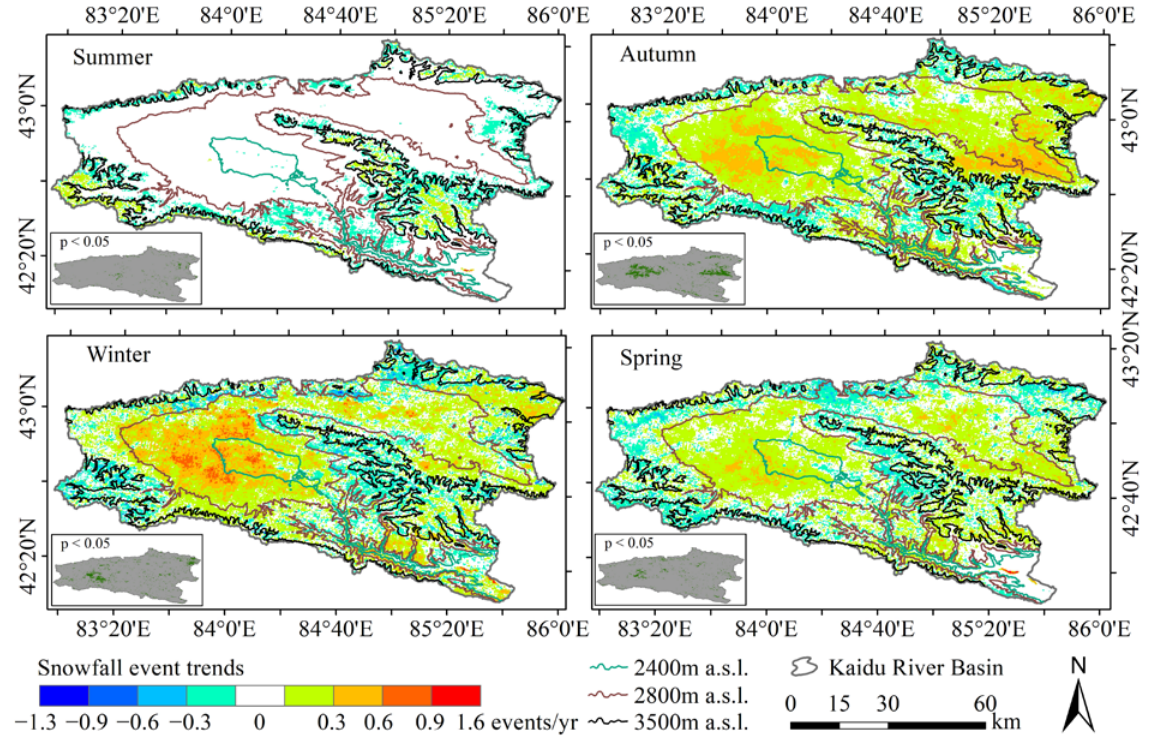
Figure 11. Spatial distributions of the seasonal trends in the frequency of snowfalls over the KRB from June 2000 to May 2020, where the green areas in the inset figure represent significant trends at a 95% ( p < 0.05) confidence level.